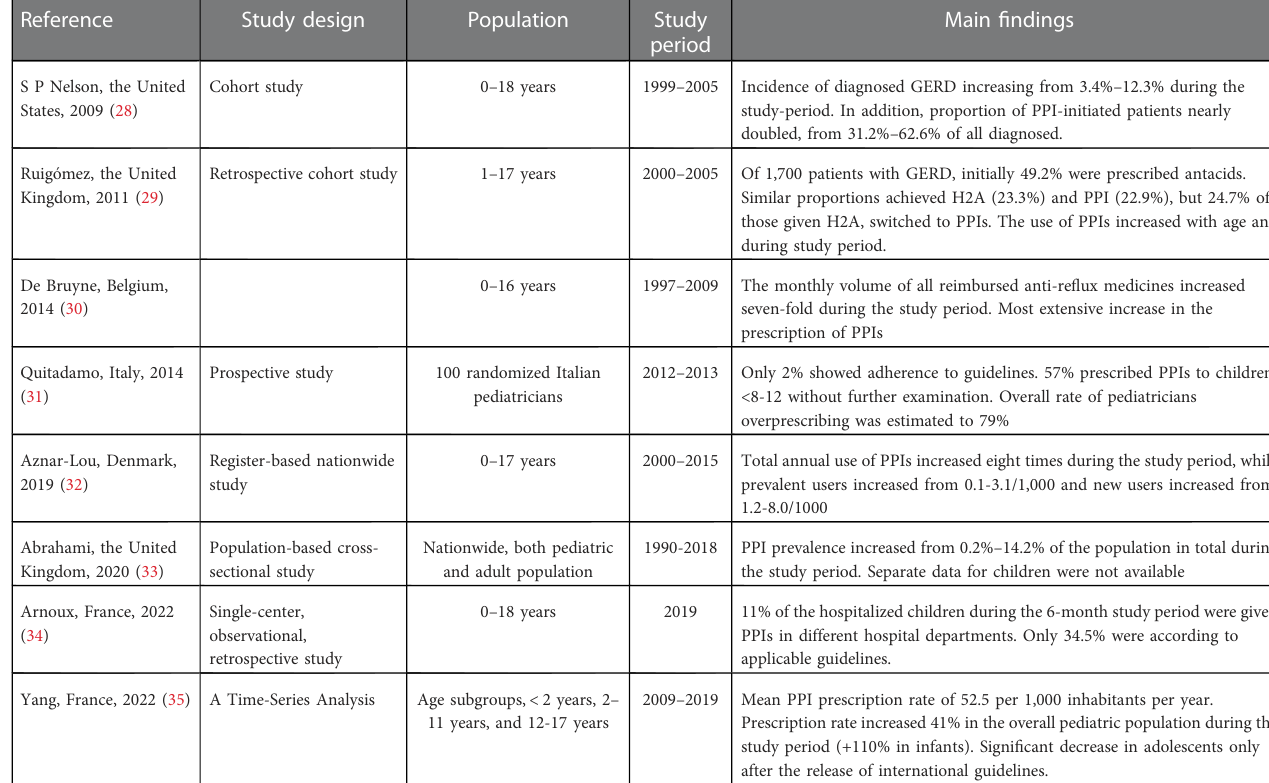
Table 2 Studies concerning the trends in the use of PPIs in children and